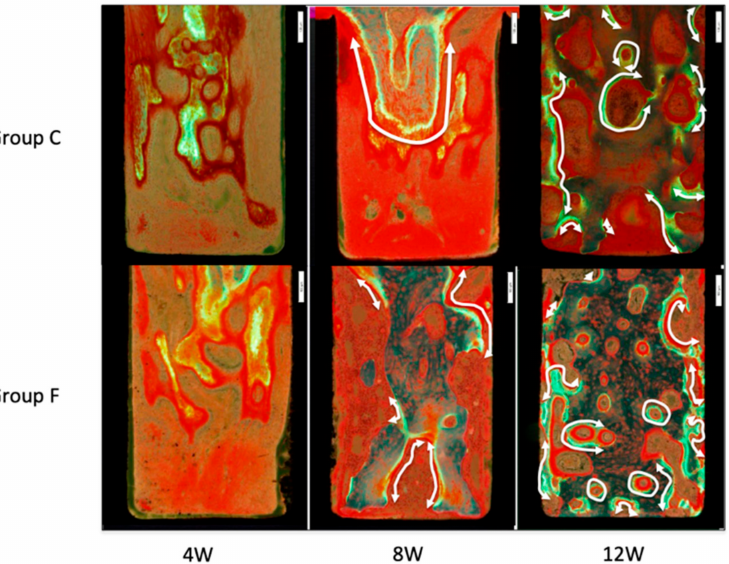
Figure 7. Microscopic images of inner surfaces of slits under fluorescent light. Newly formed bone tissue is identified with calcein-green labeling. White arrows show regions of double labeling. At Week 12, more bone was formed in Group F than in Group